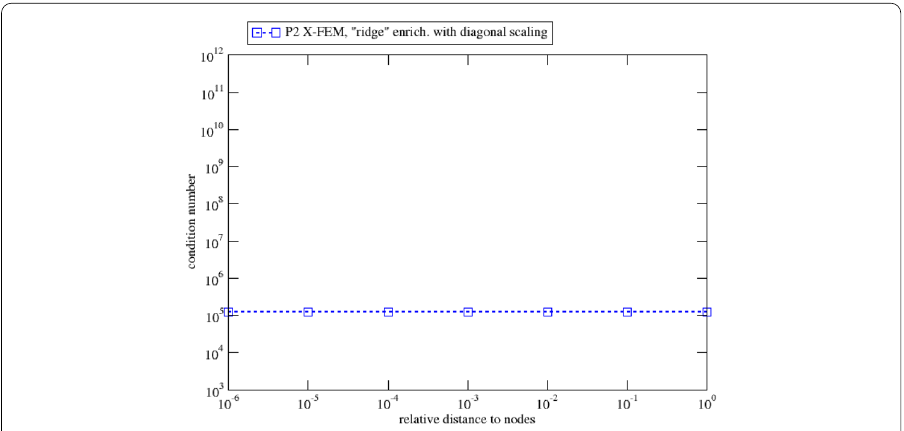
Fig. 37 Conditioning of X-FEM formulation with quadratic elements for weak discontinuities representation. With X-FEM’s ridge enrichment functions no conditioning issues are observed through the use of a diagonal